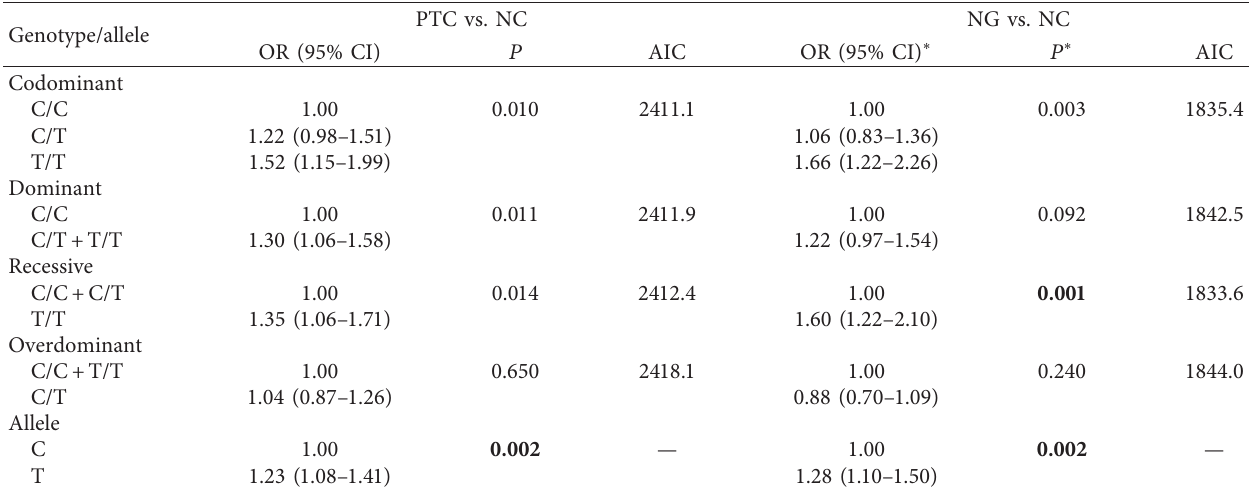
Table 3: Association between rs944289 polymorphism and PTC/NG.